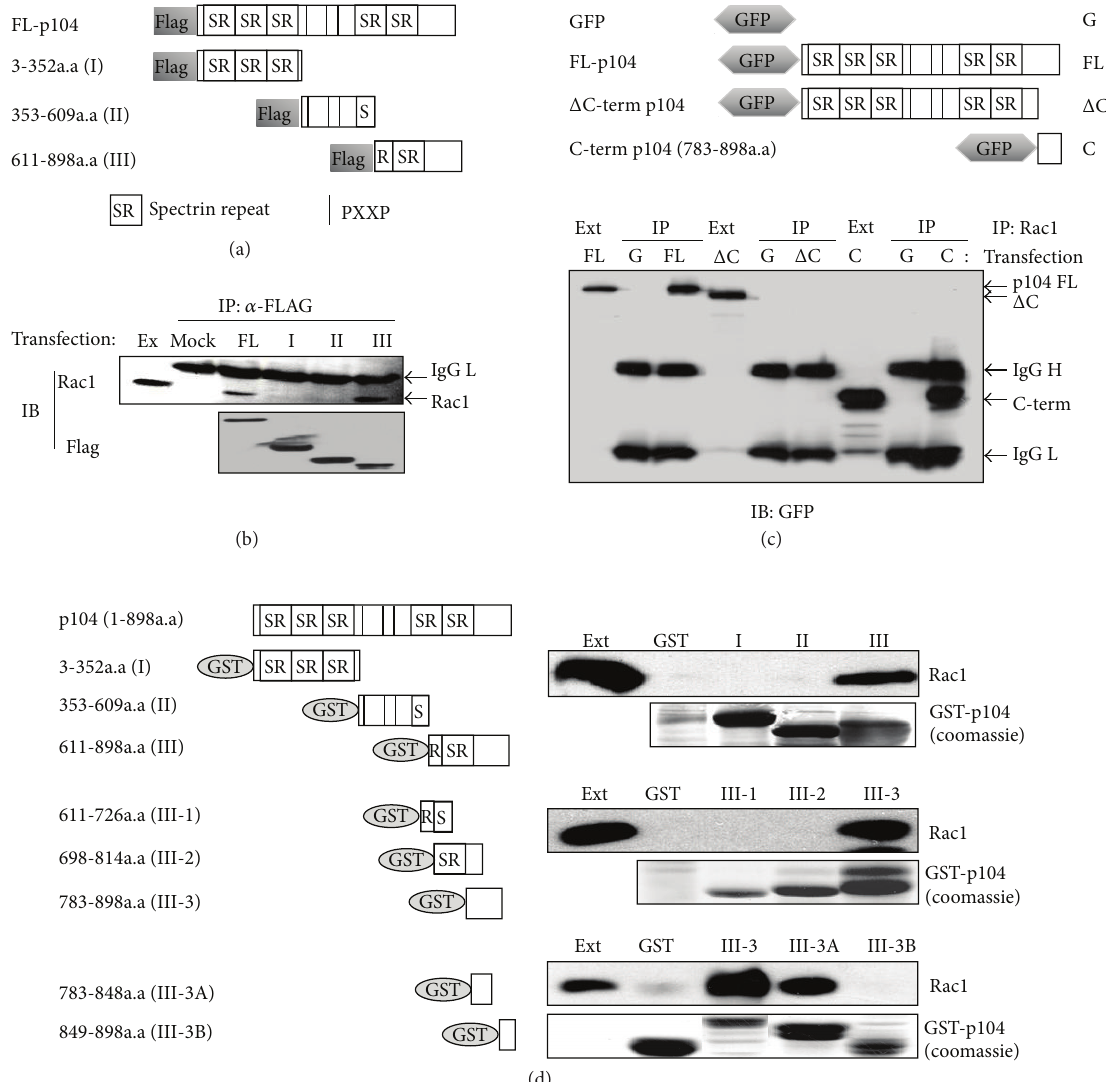
Figure 2: The carboxy-terminal region of p104 was essential for the interaction with Rac1. (a) Schematic representation of the constructs used in this experiment. p104 was divided into three regions and inserted into the pCMV Taq2B vector. Full-length (FL) 104 contains the entire open reading frame (ORF), and constructs I, II, and III contain 7–352, 353–609, and 611–898 amino acid residues, respectively.